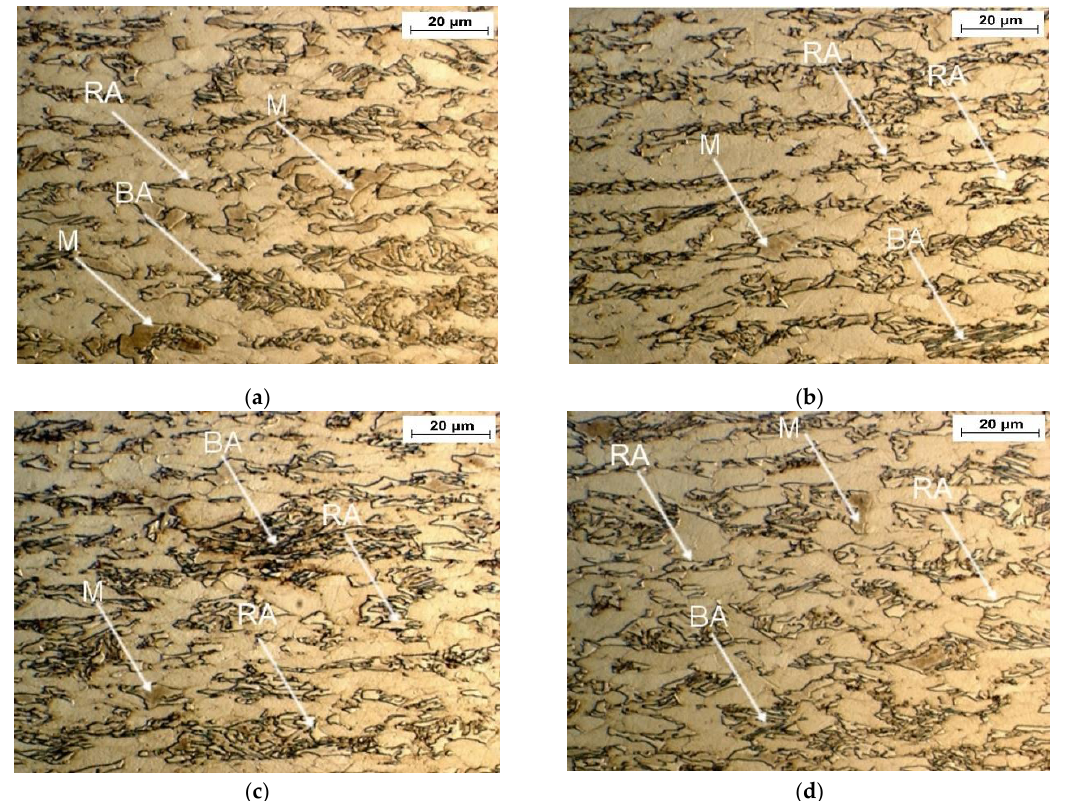
Figure 6. Optical micrographs of specimens deformed at different temperatures: 20 ( a ), 60 ( b ), 100 ( c ), and 200 °C ( d ). RA—retained austenite, BA—bainitic-austenitic islands, M—martensite.